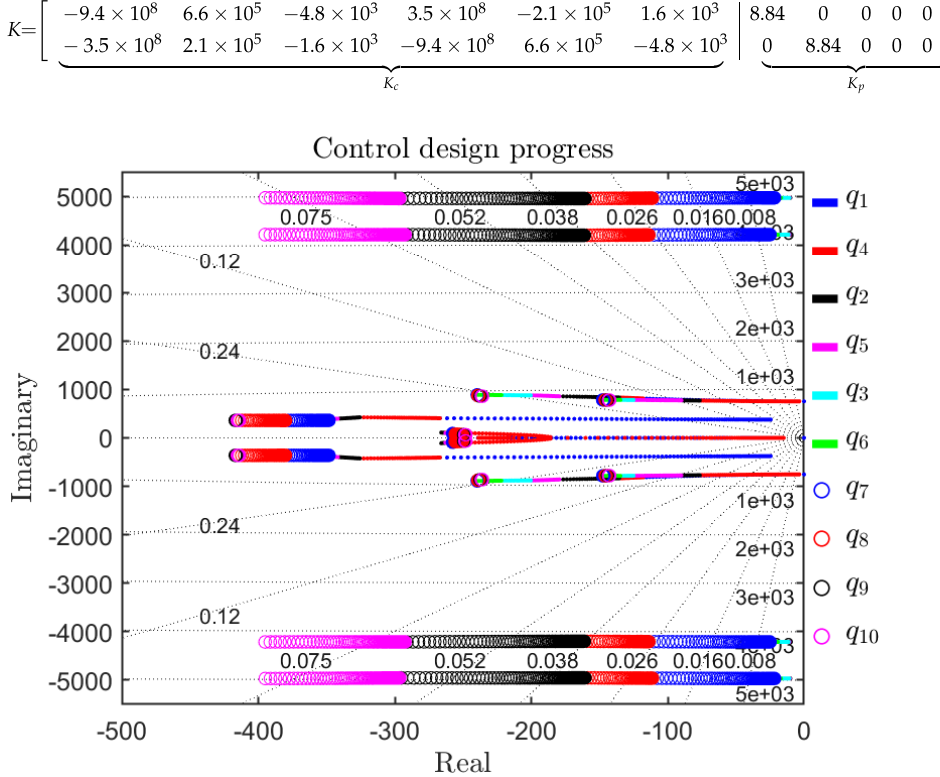
Figure 5. Loci of the closed-loop system poles for the LCL -type filter.